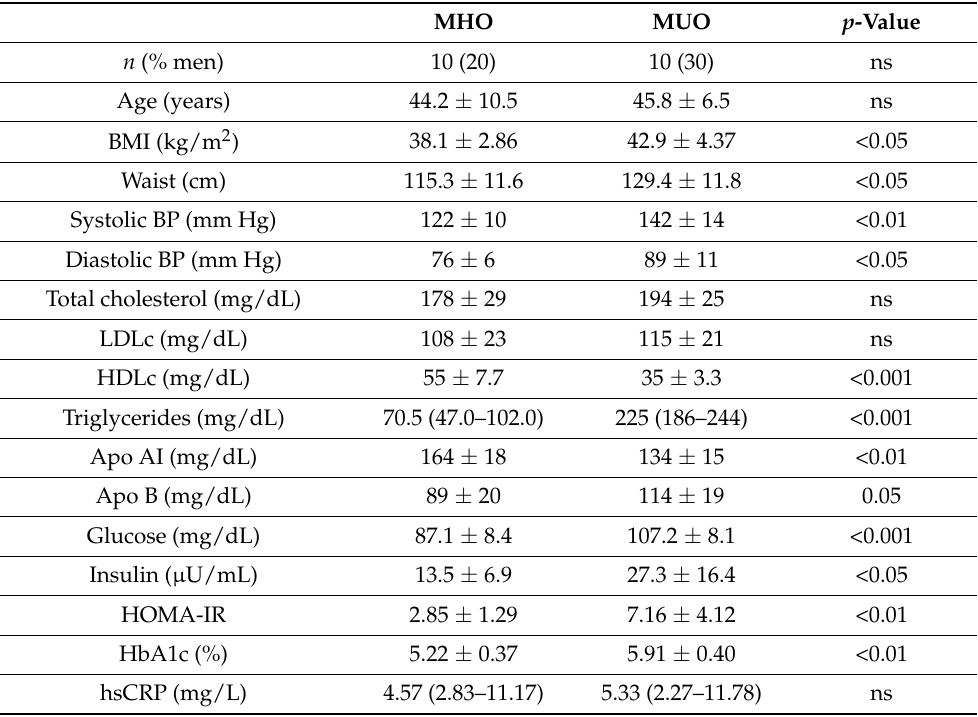
Table 1. Clinical and metabolic variables in metabolically healthy obese and metabolically unhealthy obese individuals.